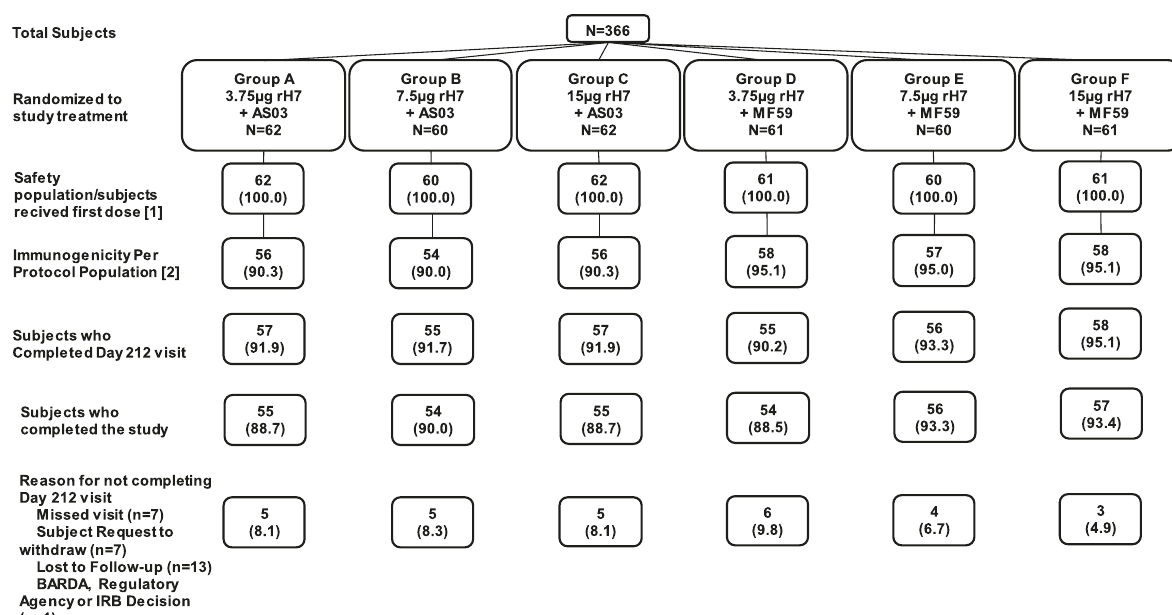
Fig. 1 Subject enrollment and randomization are shown by treatment group. The Safety Population consisted of all subjects who were randomly assigned and received at least one dose of vaccine. The immunogenicity per protocol population (IPPP) included subjects who received two full doses of randomized vaccine, had valid hemagglutination inhibition (HAI) results at the day 50 visit (primary immunogenicity endpoint), and had no major protocol deviations that might impact the assessment of